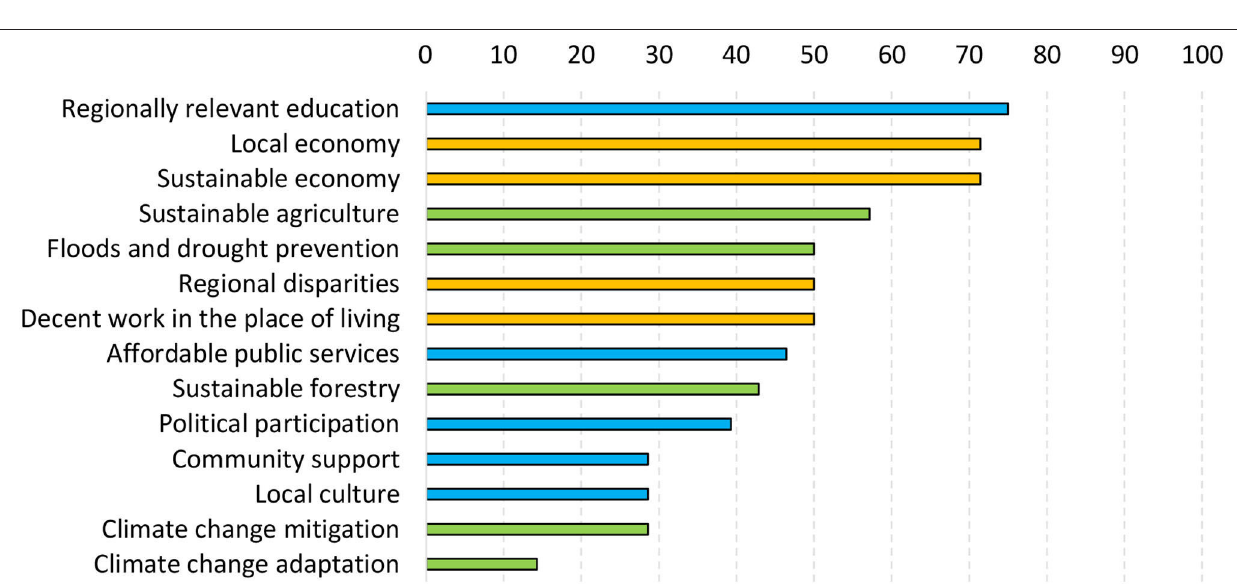
FIGURE 2 | Importance of the adapted SDGs for Czechia. Answers to the question “Rank these sustainable development goals according to their importance for Czechia as the whole country.” N = 44. The respondents were asked to rank 14 offered goals. Numbers are median ranking normalized on the 0–100 scale (100 being most important). The colors show the main dimension of the Adapted SDG: environmental is green, economic is yellow, and social is